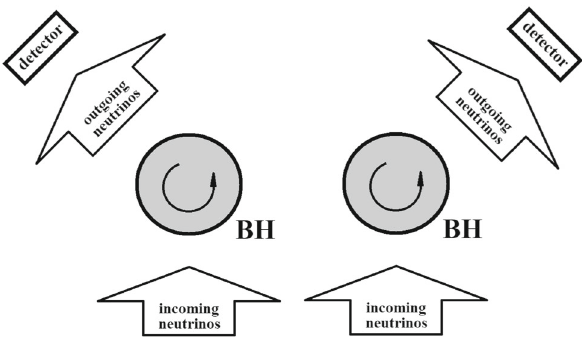
with odd powers of y